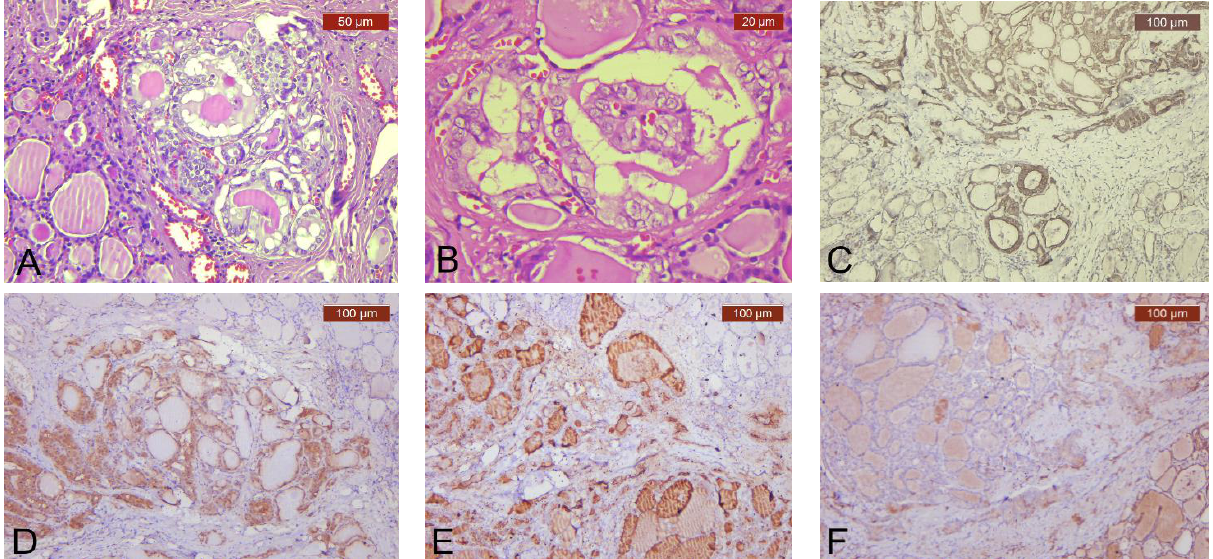
Figure 3. Histo- morphological features of TCTs’ PTC components. ( A ) Follicular PTC growth pattern (HE, ×200); ( B ) con- ventional PTC growth pattern (HE, ×400); strong and diffuse positivity of PTC component for ( C ). CK19 (IHC, anti-CK19 antibody, ×100), ( D ) galectin-3 (IHC, anti-galectin-3 antibody, ×100), ( E ) HBME1 (IHC, anti-HBME1 antibody, ×100); ( F ) total negativity for CD56 (IHC, anti-CD56 antibody,